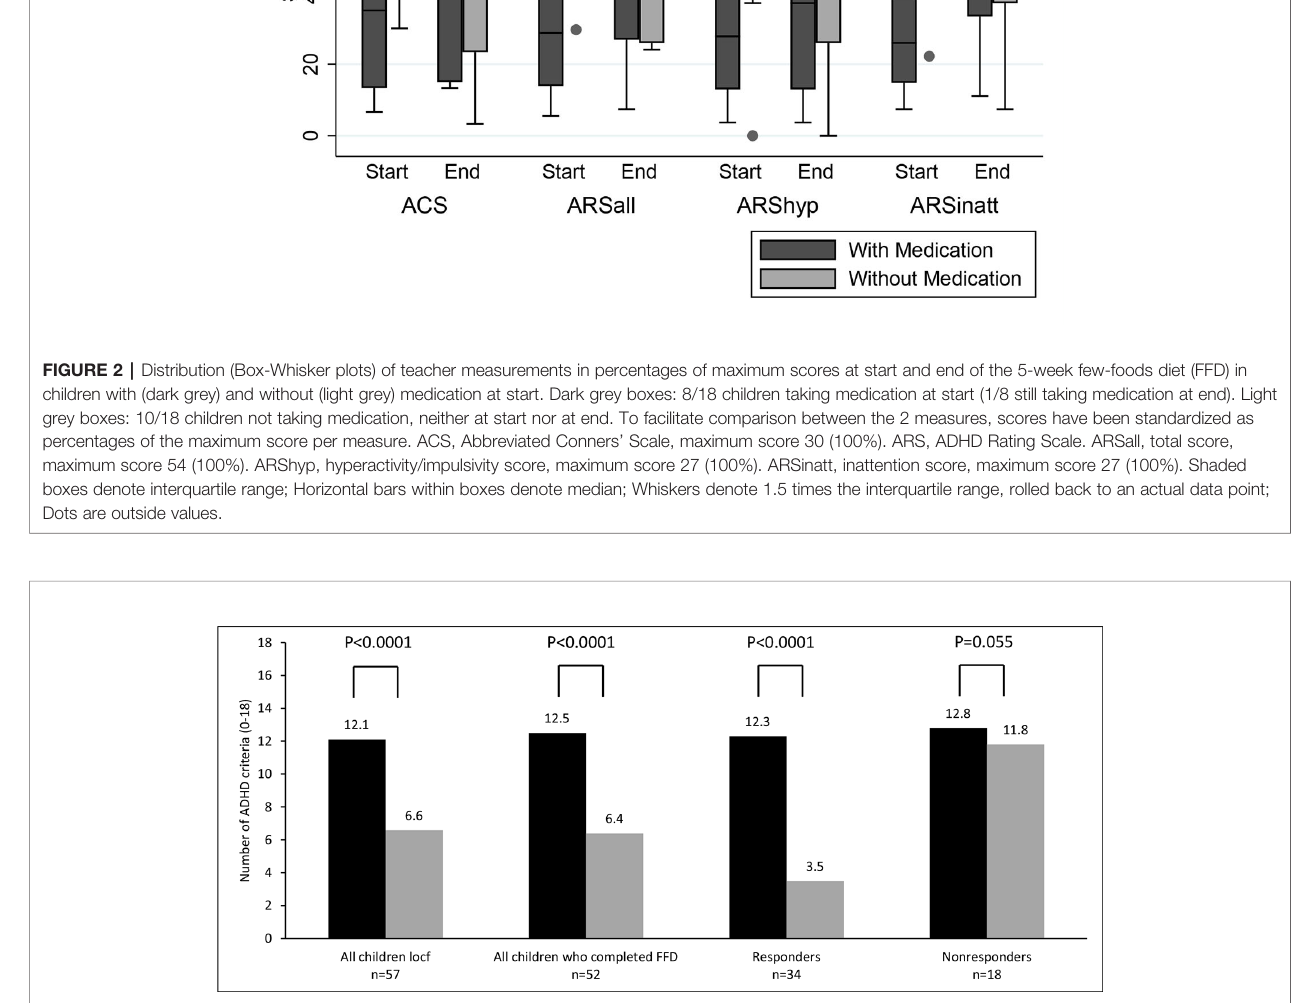
FIGURE 3 | Number of attention-de fi cit/hyperactivity disorder (ADHD) criteria (0 – 18) at T1 (black bar) and T2 (grey bar). Locf, last observation carried forward; FFD, few-foods diet; responder, at least 40% improvement; non-responder, no or less than 40% improvement.